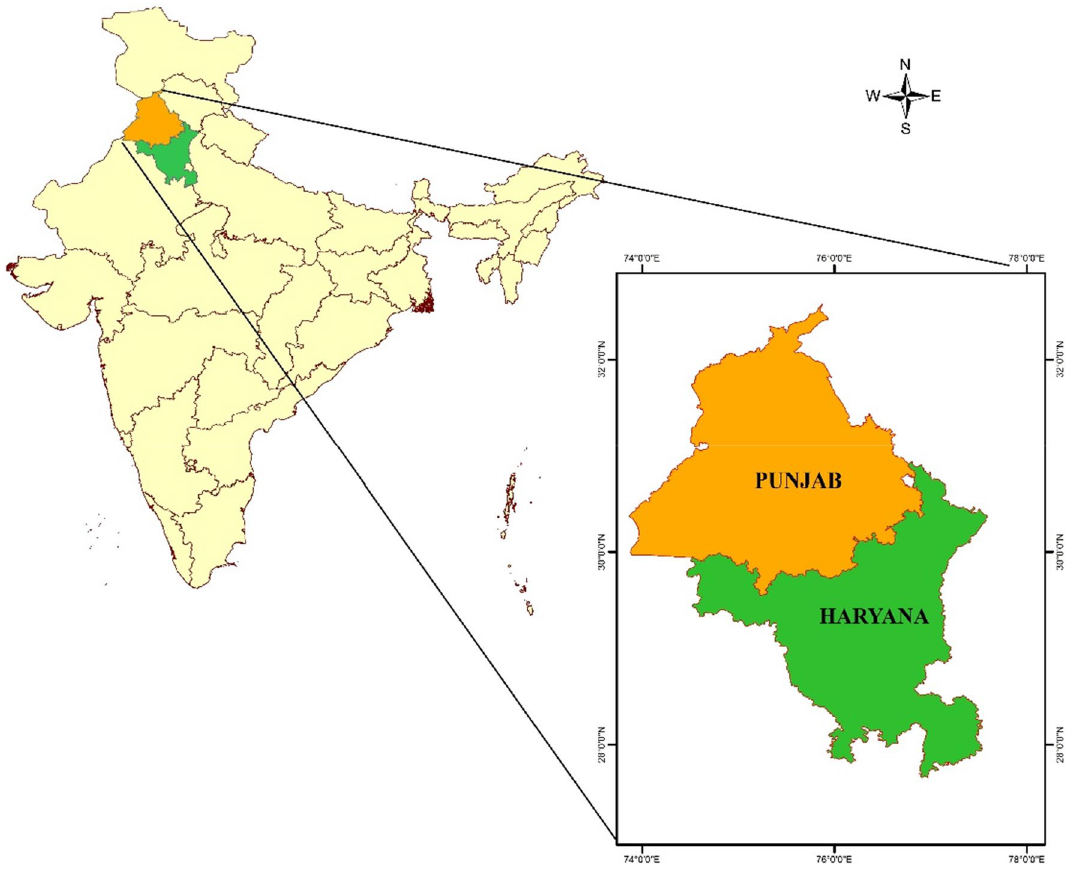
Figure 1. The geographical locations of both Punjab and Haryana states (India) selected for this study (Map created at IIRS—https:// www. iirs. gov. in/ inhou selab orato